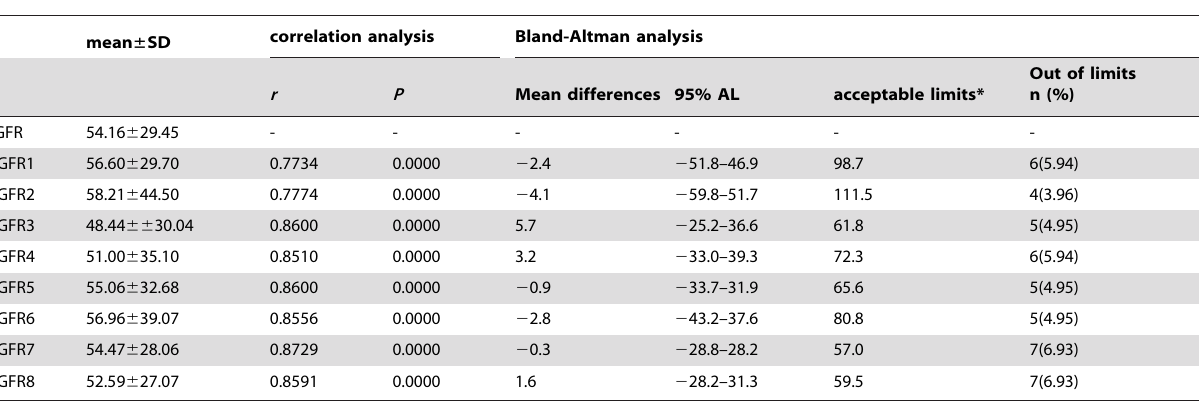
Table 2. Overall limits of agreement between eGFR and rGFR (n= 101).